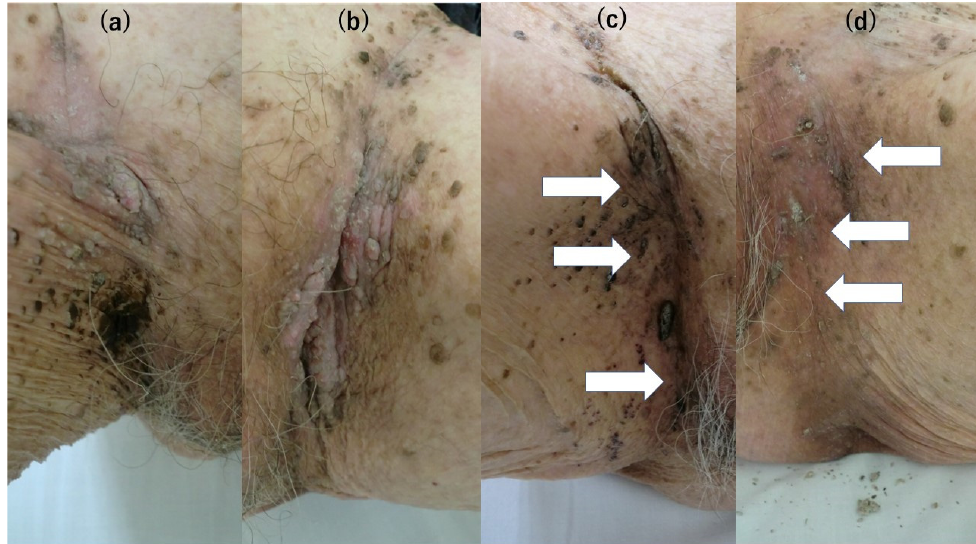
Figure 1. ( a ): SK developed at the left groin area along with the hip joint line. ( b ): SK in a part of the plaques developed at the right groin area. ( c ): SK lesion at the left groin area has recovered. The black nodules remain, but the white arrows indicate that the pinkish nodules have disappeared. A total of 90% of the areas of SK initially observed before and after the application of zinc oxide ointment disappeared. ( d ): SK lesion at the right groin area has recovered. White arrows indicate that the nodules and plaques have almost all disappeared.